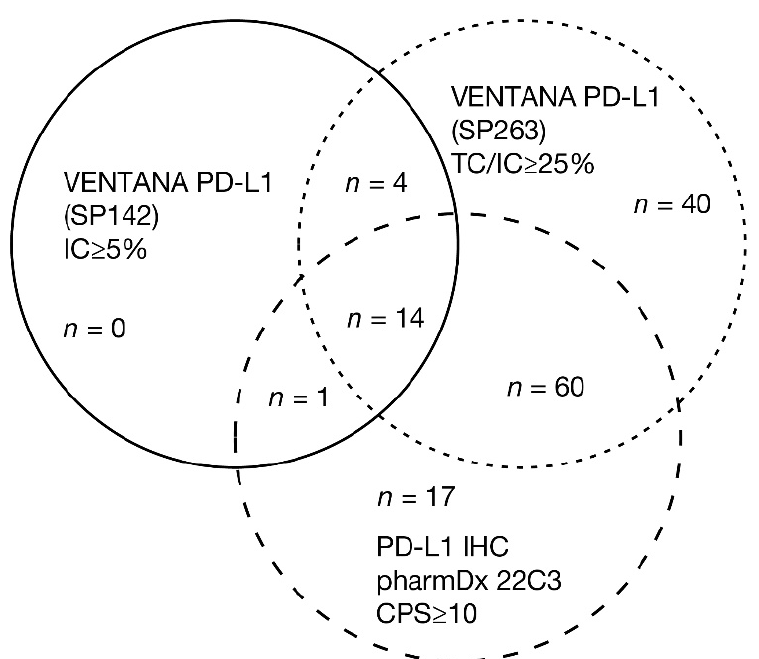
Figure 3. UC specimens classified as PD-L1 high using commercially available PD-L1 assays. The fig- ure shows the overlap of positive cases using three commercially available PD-L1 assays. In an assay comparison study, 335 UC tumor samples were stained and scored with the algorithm and cutpoint associated with that assay [48]. Of the 40% of samples deemed PD-L1 high using any assay, 12% were uniquely identified by the VENTANA PD-L1 (SP263) Assay, 5% by the PD-L1 IHC pharmDx 22C3 Assay, and none were unique to the VENTANA PD-L1 (SP142) Assay. The highest overlap